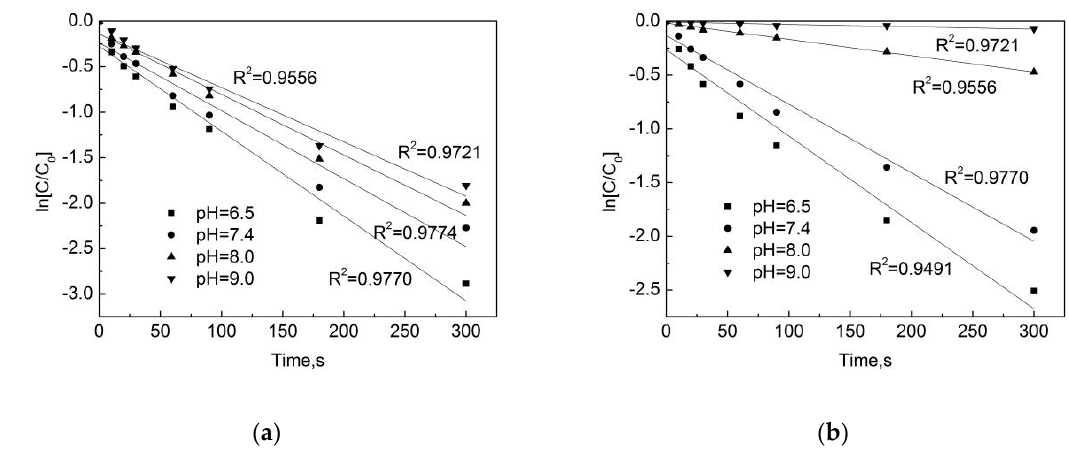
Figure 6. Dynamic fitting curves of OFL under different pHs in ( a ) the water distribution system, and in ( b ) the deionized water.